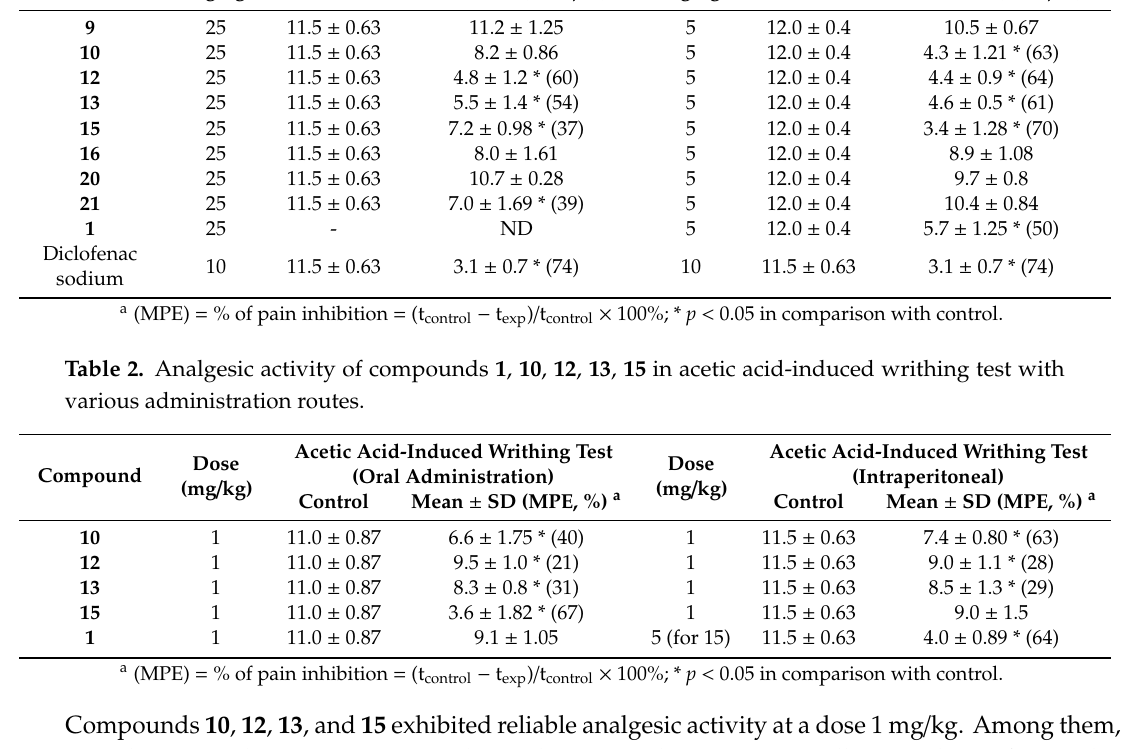
Table 1. Analgesic activity of compounds 1 , 9 , 10 , 12 , 13 , 15 , 16 , 20 , 21 and Diclofenac sodium. Compound